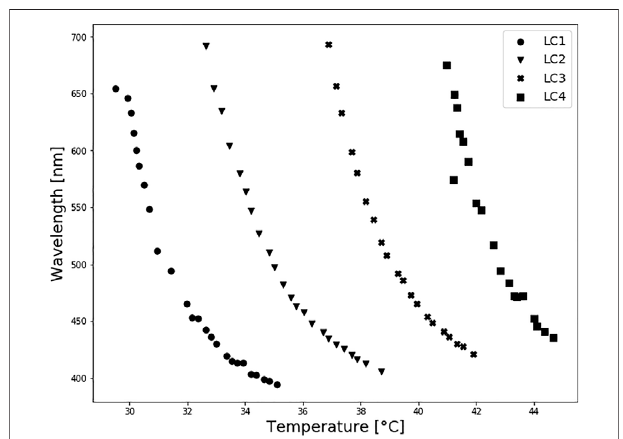
FIGURE 4 | Thermotropic LC spectrophotometry: calibration curves. All calibration curves showed a second-order polynomial trend.